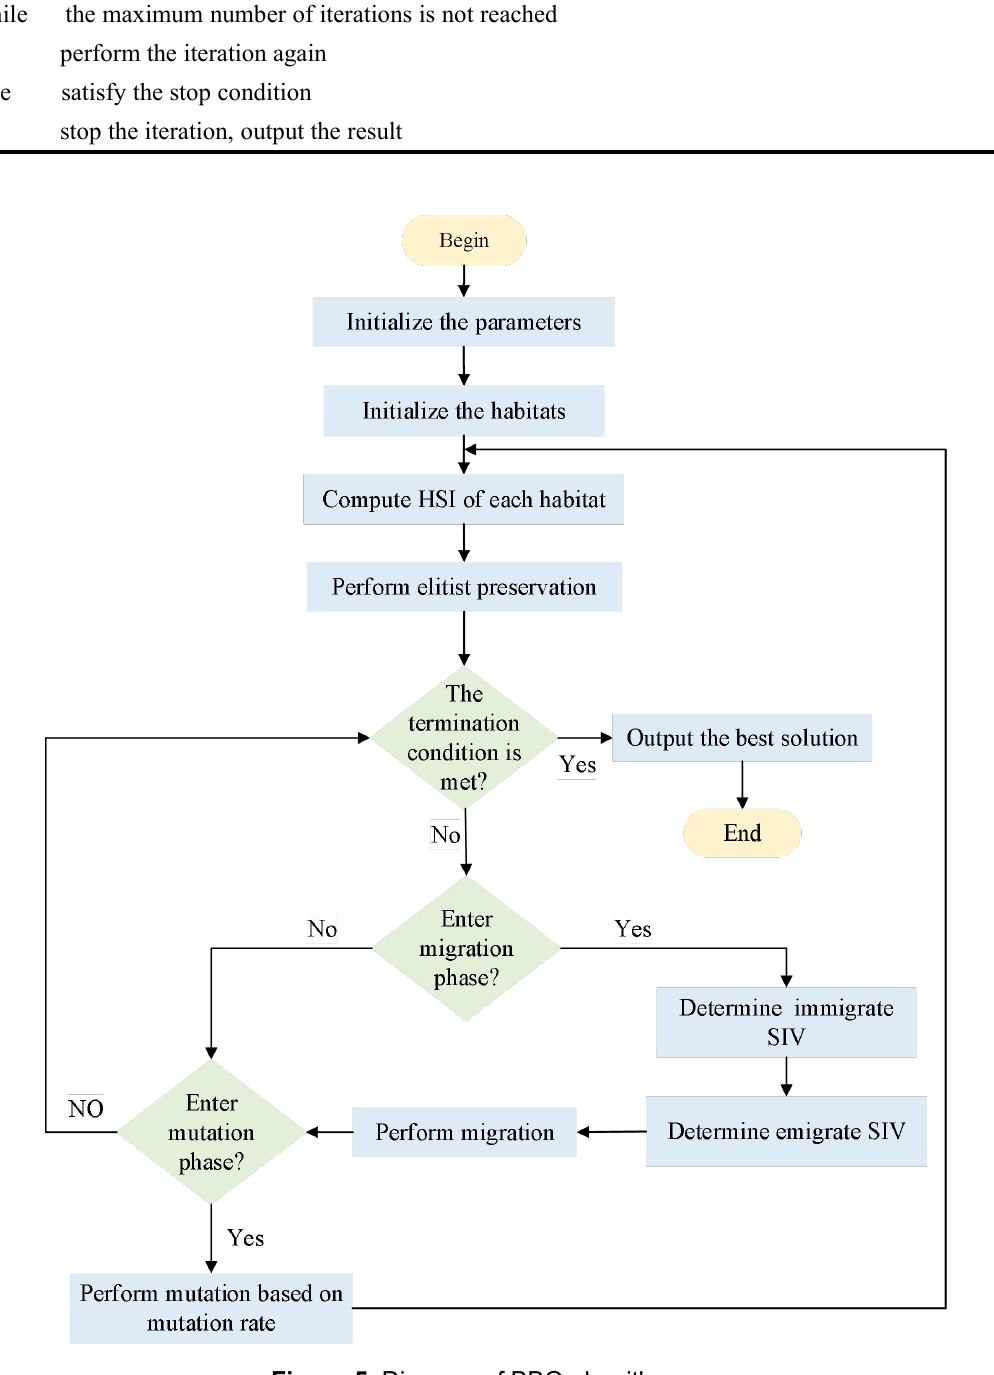
Figure 5. Diagram of BBO